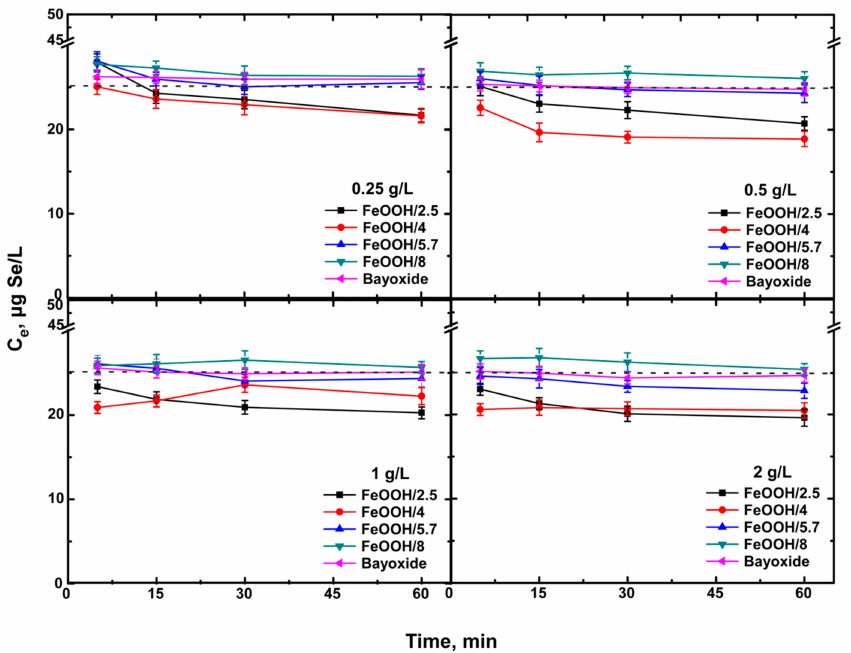
Figure 3. Adsorption of selenium species onto several FeOOHs materials in relation to the adsorbent dose and to contact time. Experimental conditions: the initial Se concentration in the samples is a mixture containing 25 µ g Se(IV)/L and 25 µ g Se(VI)/L (i.e., total Se 50 µ g/L), at pH 7.3 ± 0.2, and temperature 20 ◦ C.